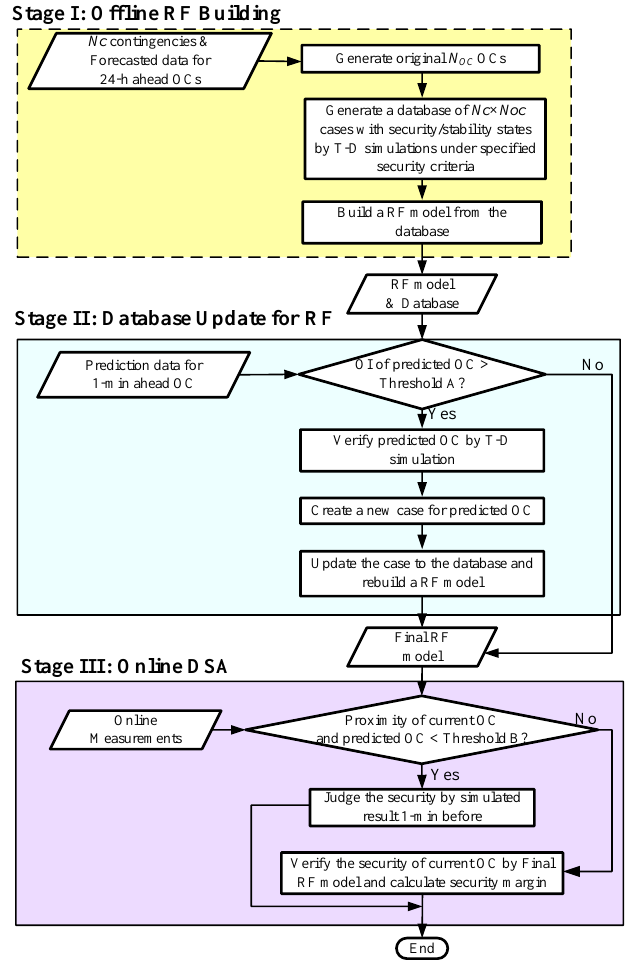
Figure 6. The flowchart of the Random Forest based online DSA scheme.